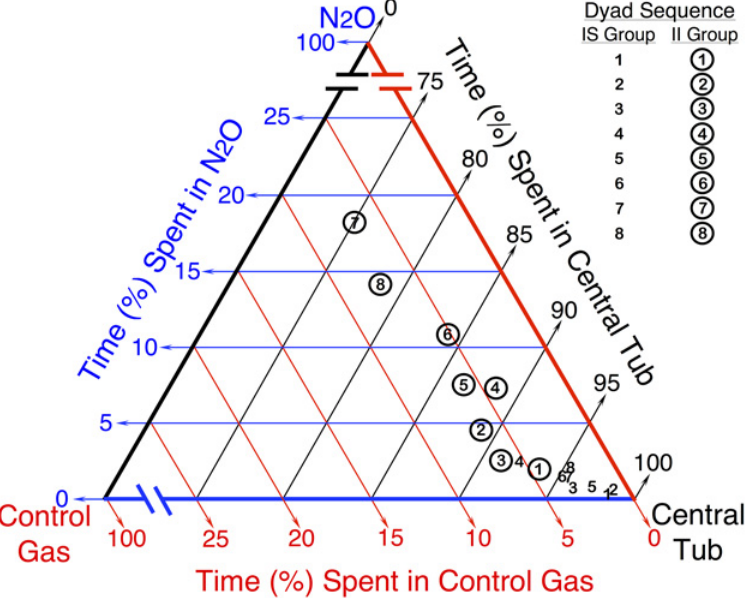
Fig 2. N 2 O Self-Administration Data for Initially Sensitive and Initially Insensitive Rats. Ternary diagram depicting the centered geometric mean proportions of time spent in each chamber for each of the eight 44-h dyads during N 2 O availability. The numbers 1 – 8 depicted in the figure represent the sequential order of self- administration dyads. Circled numbers represent dyads for initially insensitive rats (II, n = 16) while uncircled numbers represent dyads for the initially sensitive rats (IS, n = 16). The position of each point relative to the three color-coded axes indicates the proportion of time spent in the central tub (black), control gas chamber (red), and 60% N 2 O chamber (blue) during a 44-h